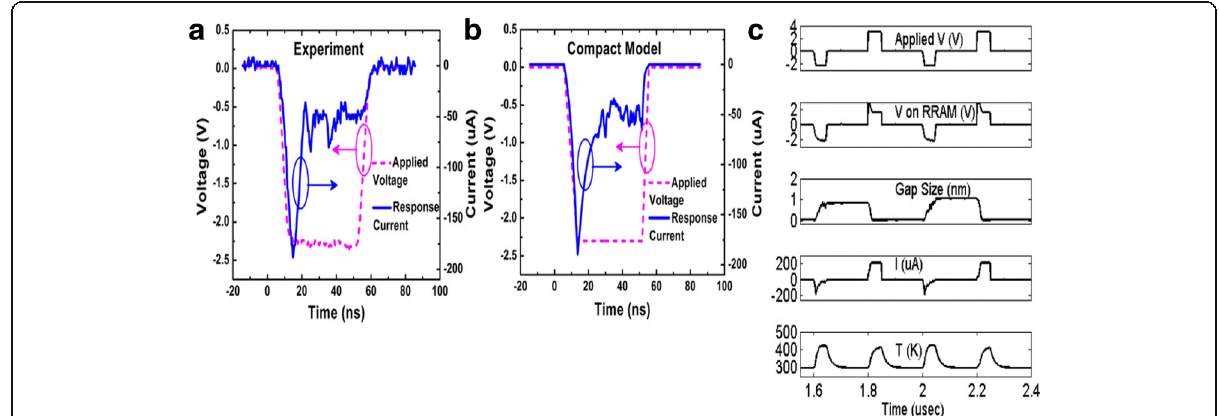
Fig. 10 a Experimental and b simulated transient responses of a HfO x RRAM device to the − 2.3 V 50 ns input pulses. The experimental result is reported elsewhere [144] and included here in a for convenience. c In a larger time range, the simulated transient response for the same device including the gap size and temperature is shown. Current compliance set at 200 μ A in simulation